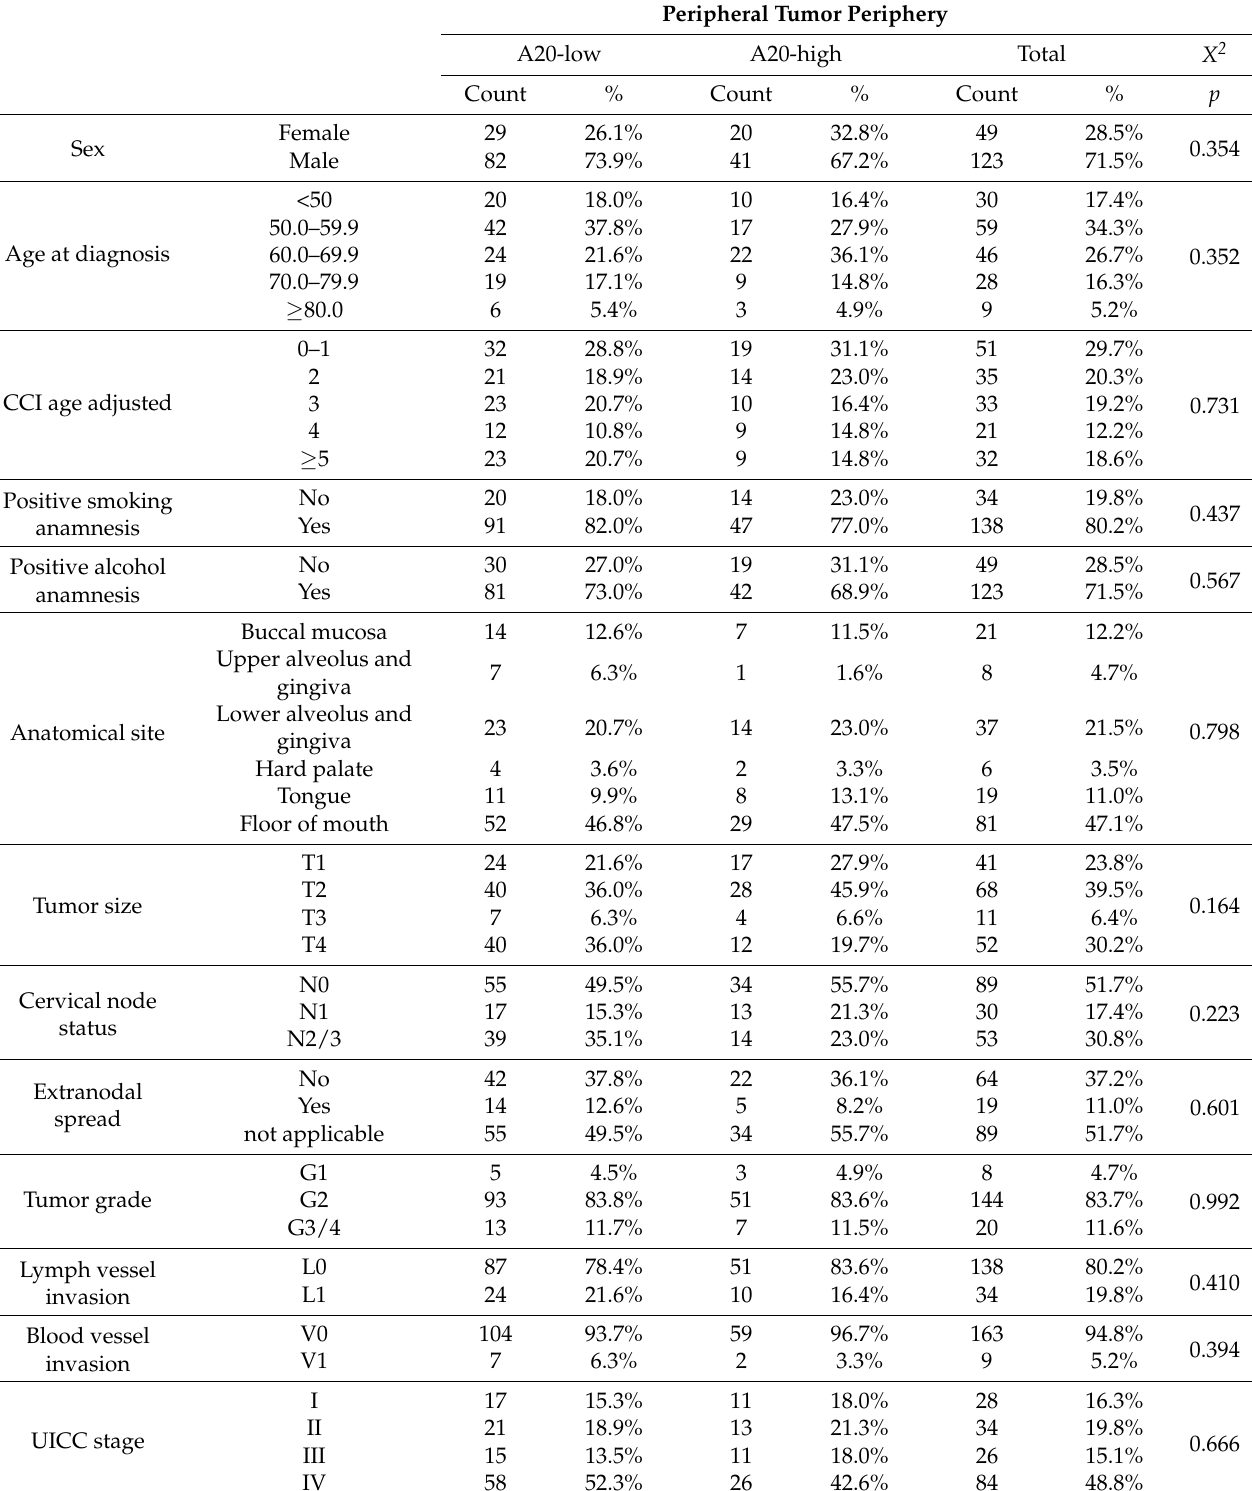
Table 1. Patients’ characteristics according to A20 expression within stromal CD3+ T cells at tumor periphery ( n =